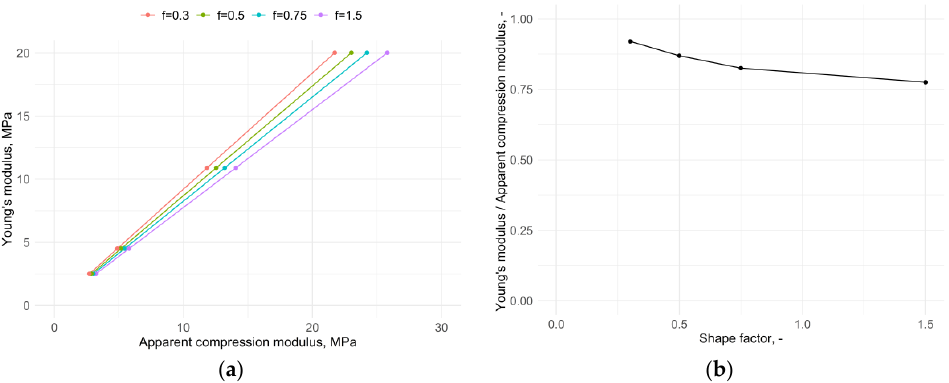
Figure 7. ( a ) The relation between Young and apparent compression moduli; ( b ) Ratio between moduli according to shape factor.